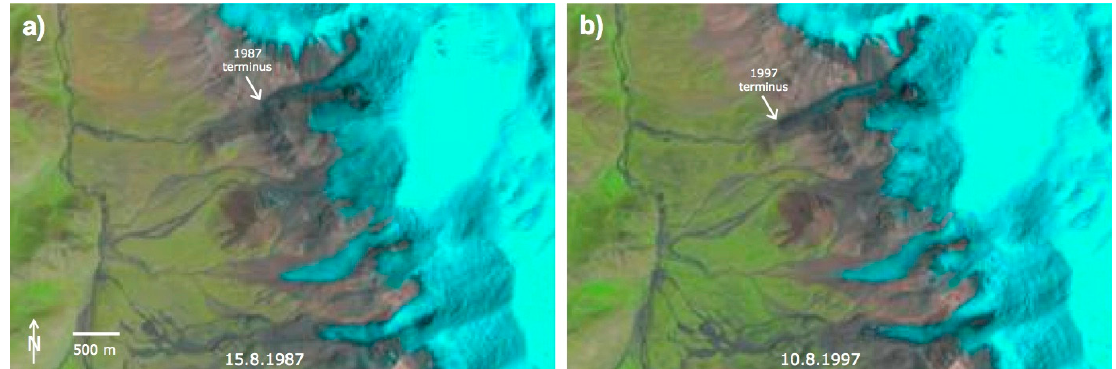
Figure 4. Landsat images from (a) 15 August 1987 and (b) 10 August 1997 showing the first surge of the glacier. The false colour images are showing (clean) ice and snow in cyan, rocks and gravel in pink to purple, and vegetation in light green. Image source: earthexplorer.usgs.gov.